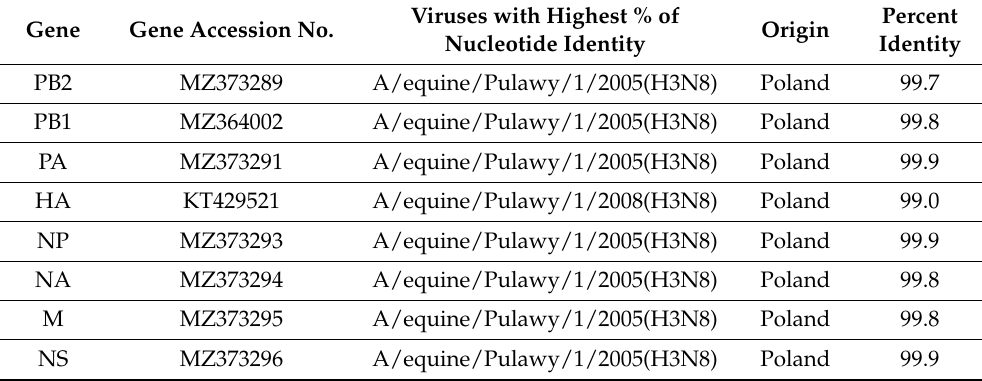
Table 2. Equine influenza viruses with the highest nucleotide identity to ITA/2005/horse/Bari, deter- mined by Basic Local Alignment Search Tool Nucleotide (BLASTn) (consulted on 28 February 2023). Viruses with Highest % Gene Gene Accession No.